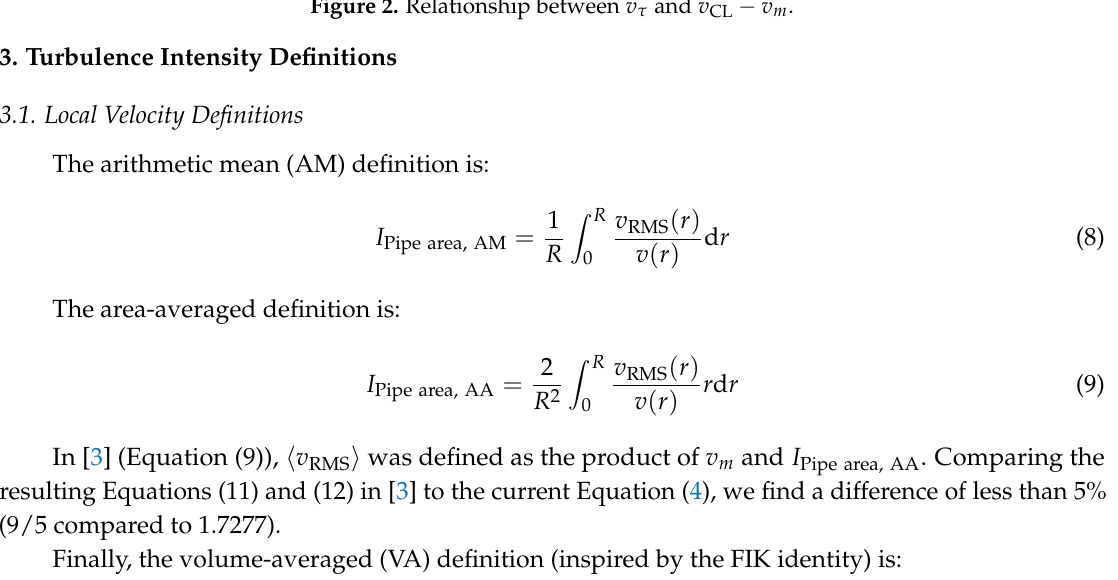
Figure 2. Relationship between v τ and v CL − v m